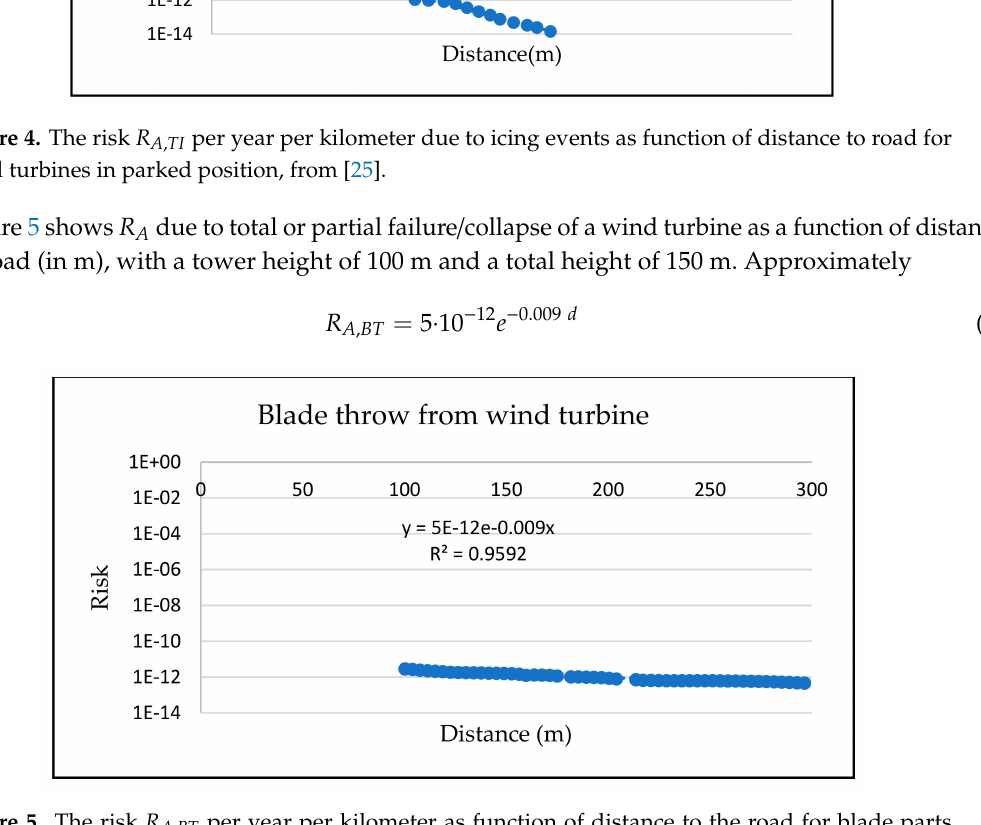
Figure 5. The risk R A , BT per year per kilometer as function of distance to the road for blade parts thrown away from the wind turbine, from